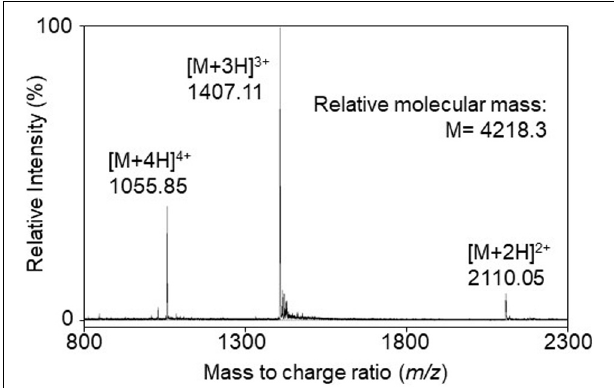
FIGURE 1 | The electrospray ionization time-of-flight (ESI-TOF) mass spectrum of the purified bacteriocin, kunkecin A, produced by A. kunkeei FF30-6. Multiple charged molecular ions were detected and are indicated.